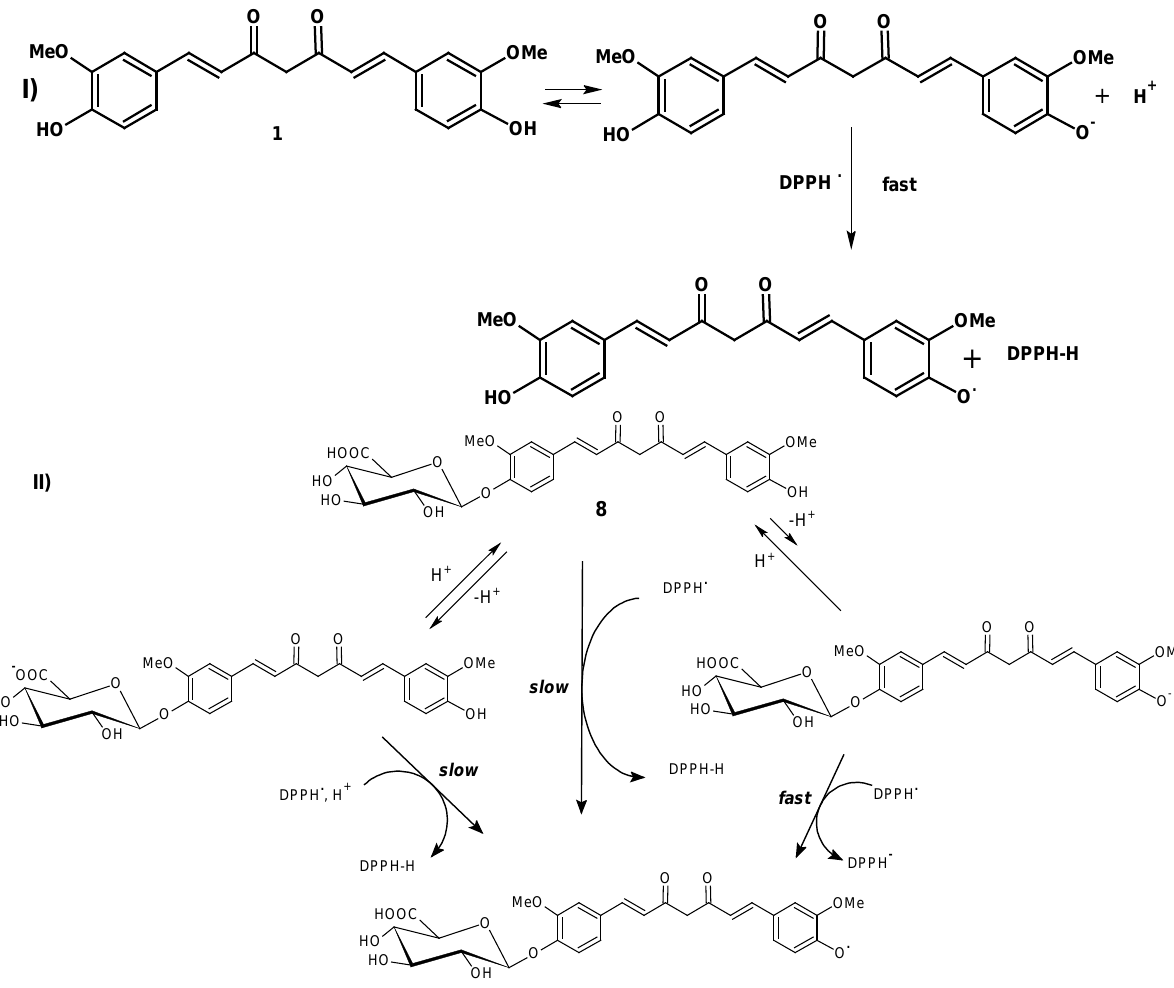
Figure 2. Possible sequential proton loss electron transfer (SPLET) pathway of ( I ) curcumin ( 1 ) and ( II ) curcumin monoglucuronide ( 8